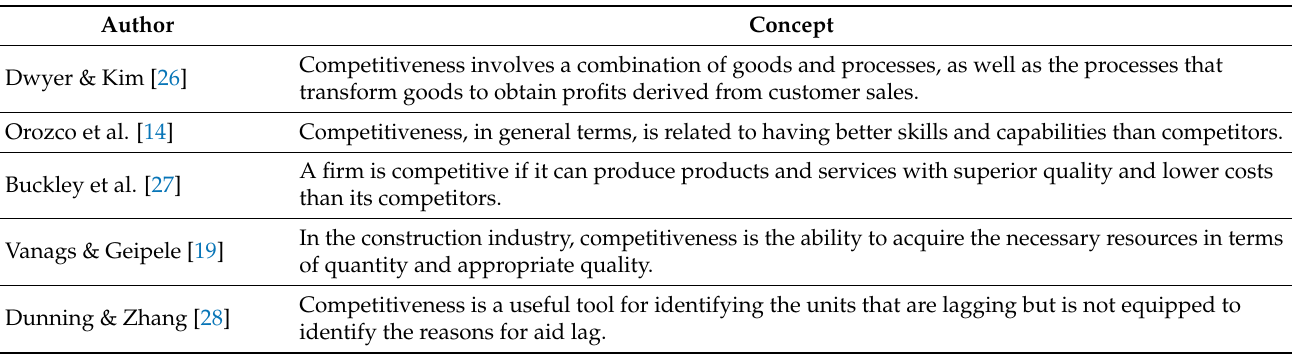
Table 1. The concept of competitiveness in the